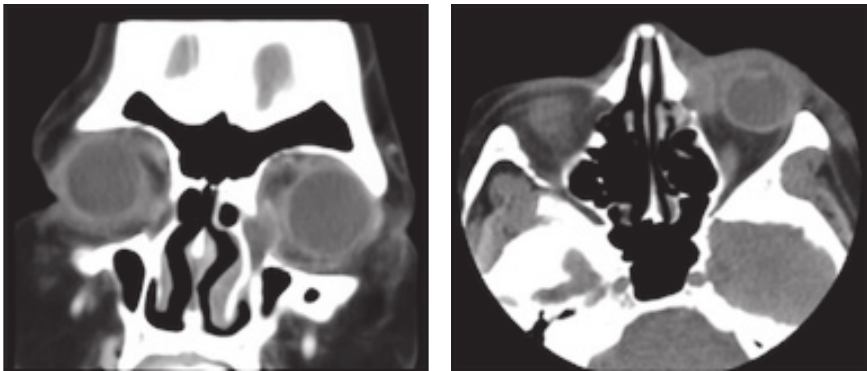
Figure1:CoronalandaxialCToftheorbitswithcontrastshowinganenlargedleftlacrimalsacandpreseptalinflammatorychangesconsistent with acute dacryocystitis with preseptal cellulitis.